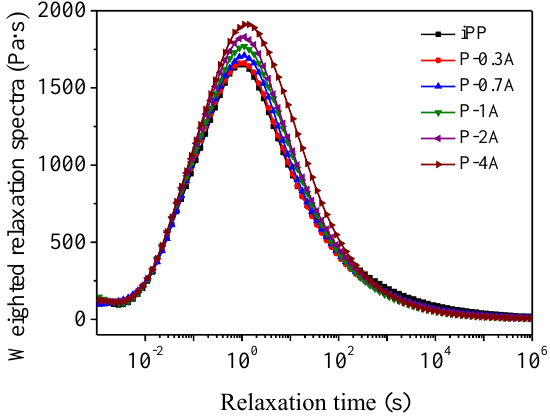
Figure 3. Complex viscosity as a function of angular frequency for iPP/ABS blends.